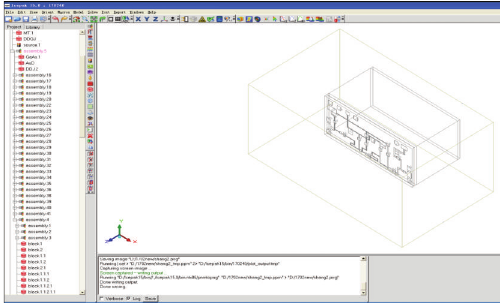
Figure 11: The example GUI window from